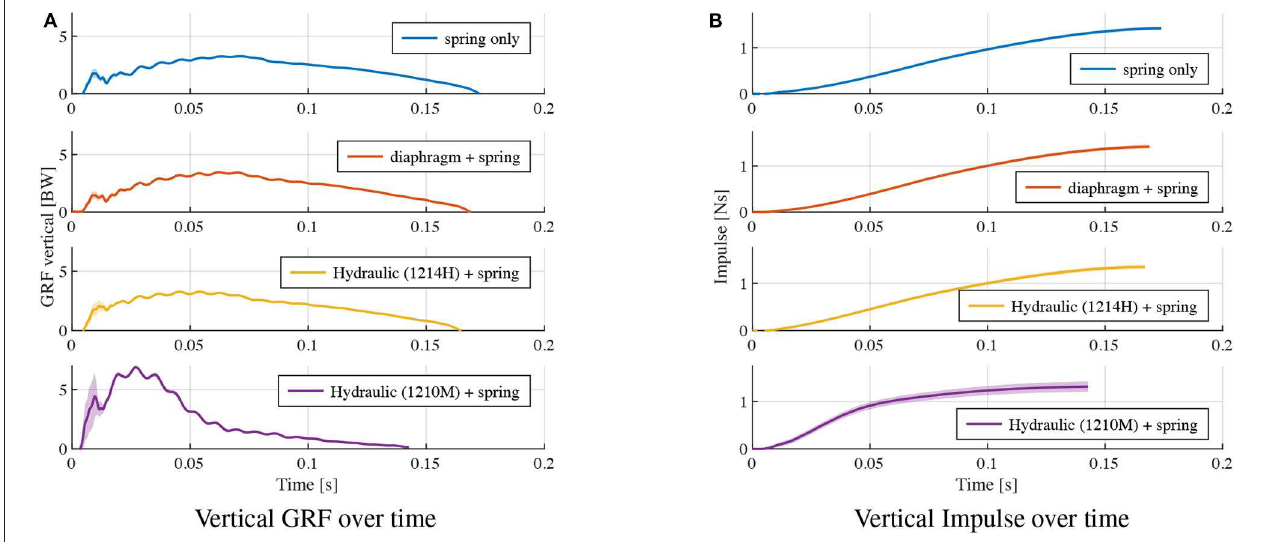
FIGURE 11 | Ground reaction forces: (A) shows the vertical GRF and (B) the corresponding instantaneous vertical impulse over time, for the leg drop experiments in Figures 8 – 10 .